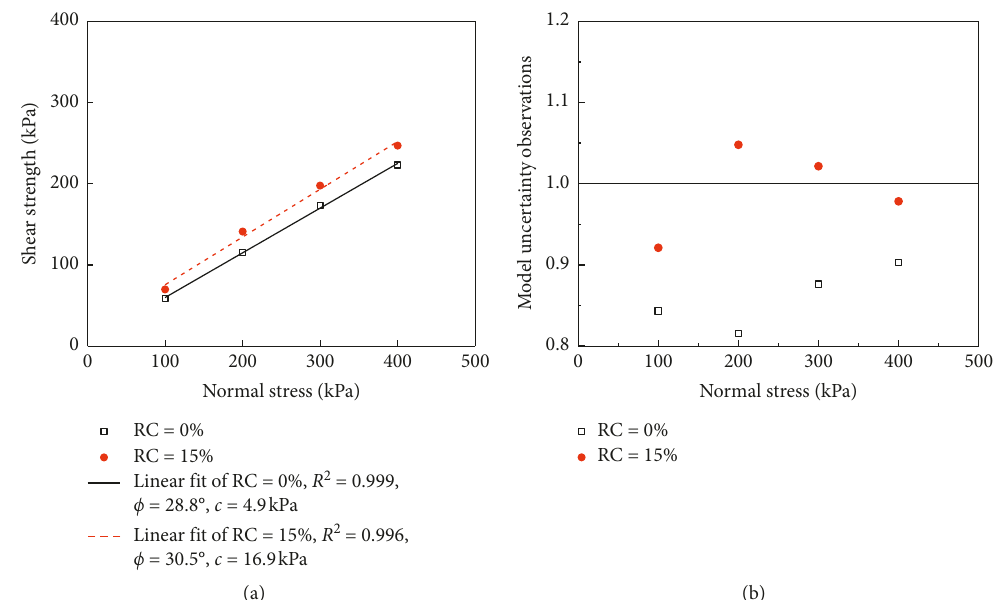
Figure 6: Calculations of cohesion and internal friction angle through Mohr–Coulomb criteria. (a) Fitting results. (b) Model uncertainty observations θ versus normal stress.